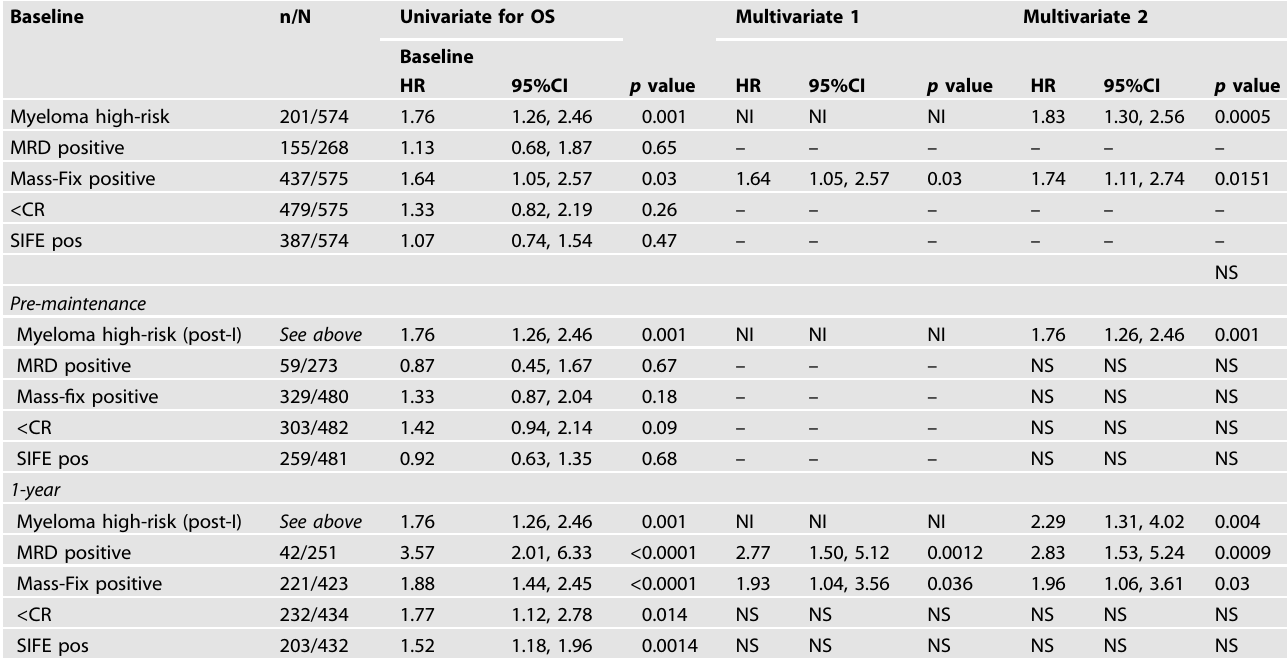
Table 3. Overall survival, univariate and multivariate